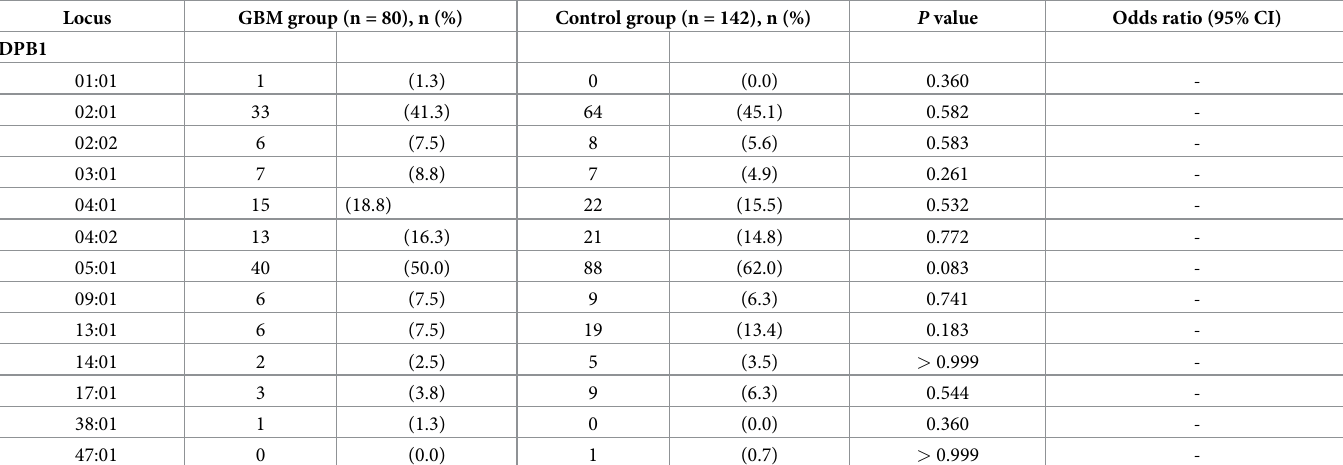
resolution of HLA genotypes of normal Korean’s individuals (control group) and those of GBM patients (GBM group). In this study, we showed that the frequencies of HLA-A � 26:02 (OR 0.22 CI 0.05–0.98), HLA-C � 08:01 (OR 0.29 CI 0.10–0.87), and HLA-DRB1 � 08:03 (OR 0.32 CI 0.11–0.98) were significantly decreased, while the frequency of HLA-C � 04:01 (OR 2.29 CI 1.05–4.97) was significantly increased. Analysis of haplotypes and frequencies showed that DRB1 � 14:05-DQB1 � 05:03 was significantly decreased in the GBM group (OR 0.22 CI 0.05– 0.98). Our findings support a study evaluating association of HLA genes with autoimmune dis- ease in Koreans. While the history of autoimmune disease was considered as a protective factor for glioma development, previous study found increased frequency of HLA-DRB1 � 08:03 and